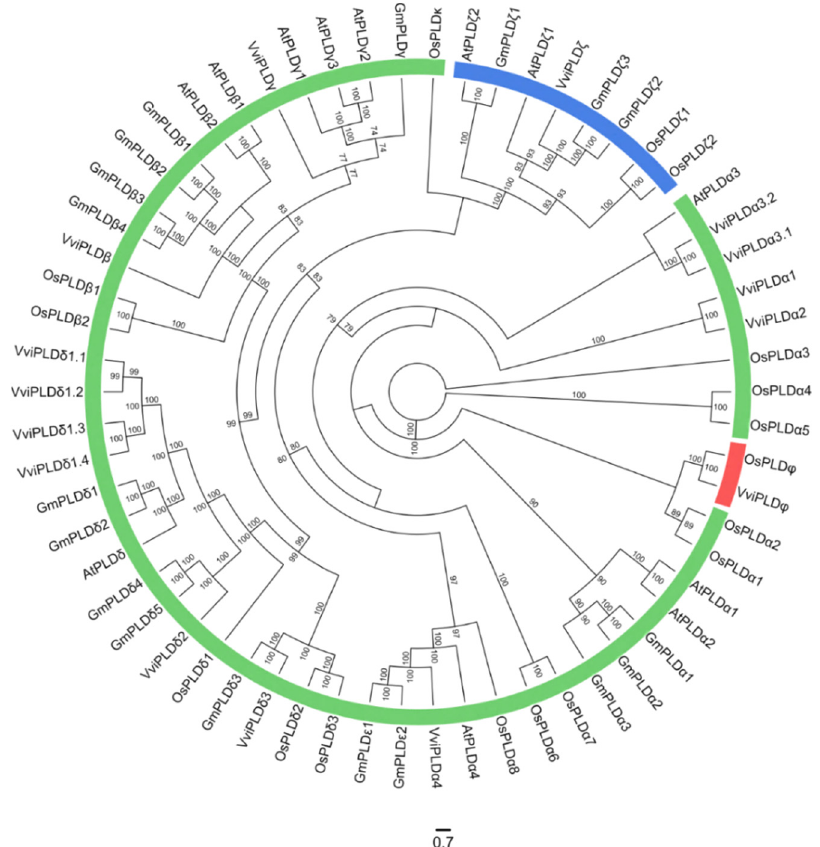
Figure 2. Maximum likelihood phylogenetic tree based on 62 Phospholipases D proteins from Arabidopsis thaliana (At), Oriza sativa (Os), Glycine max (Gm) and Vitis vinifera (Vvi). Different groups are represented by different colours: C2-PLD in green, PXPH-PLD in blue and SP-PLD in red. The numbers above the branches show bootstrap values. The scale bar represents the number of estimated changes per branch length.